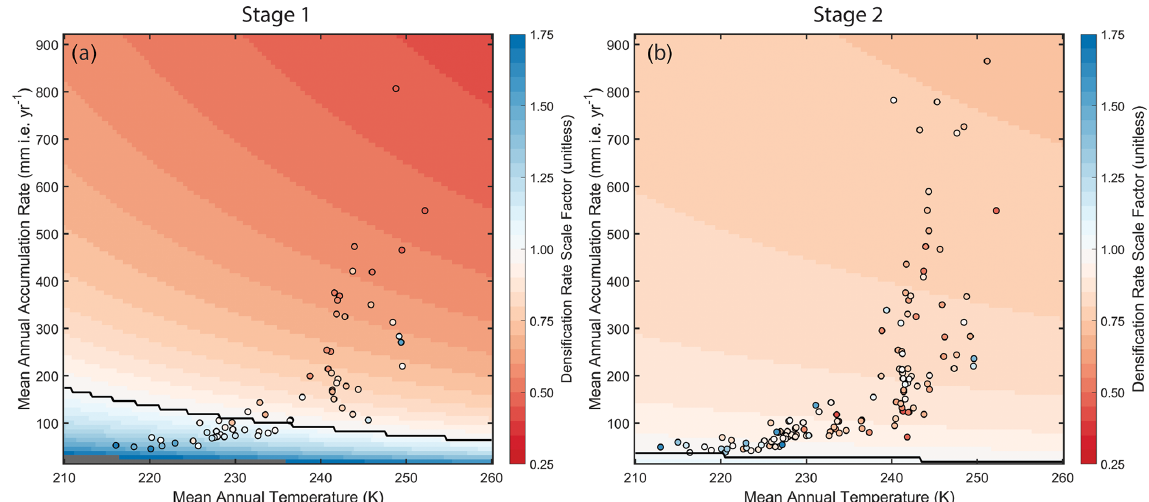
Figure 2. The dry-snow densification calibration coefficients for (a) stage 1, R 0 , and (b) stage 2, R 1 (Sect. 2.1.3; Eqs. 11–12, 15), over a range of mean annual temperatures and snow accumulation rates provide the background color contours. The coefficients derived for each of the calibration sites are plotted as closed circles, colored by their scale factor (i.e., calibration coefficients). The background color contours are derived directly from the calibrated R 0 and R 1 equations. The circles each represent the calibration coefficient derived directly from the depth–density profile at each calibration site. The black contour separates the region of enhanced densification (blue) from the region of reduced densification (red).